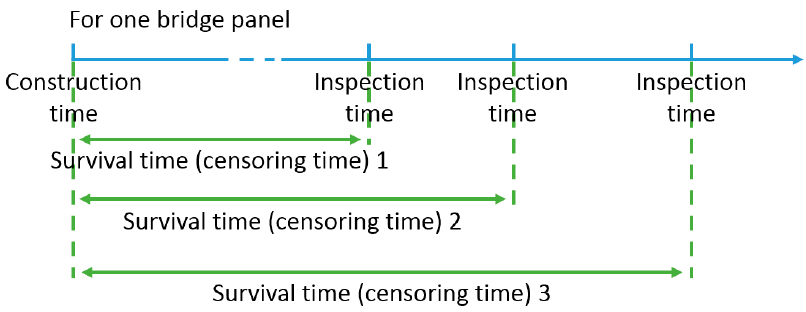
Figure 4. Previous survival time calculation (from Yamazaki and Ishida (2015)).